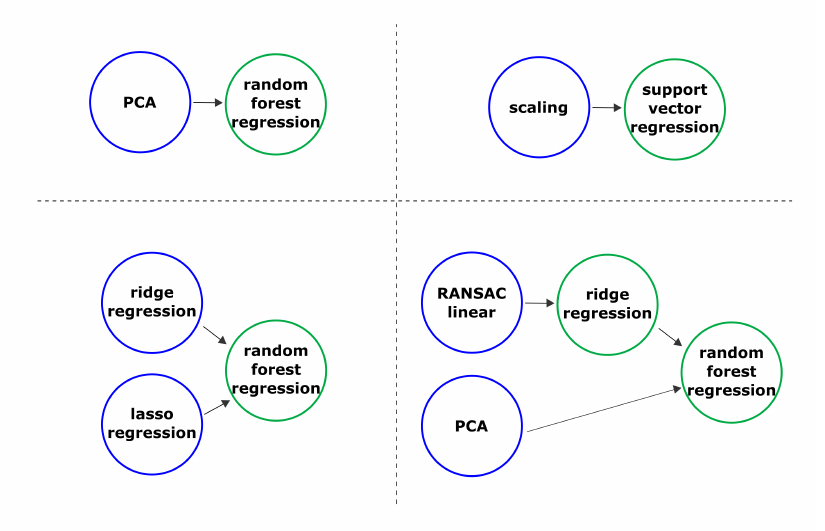
Figure 10. Several modelling pipelines generated by AutoML-based approach and used for the flood